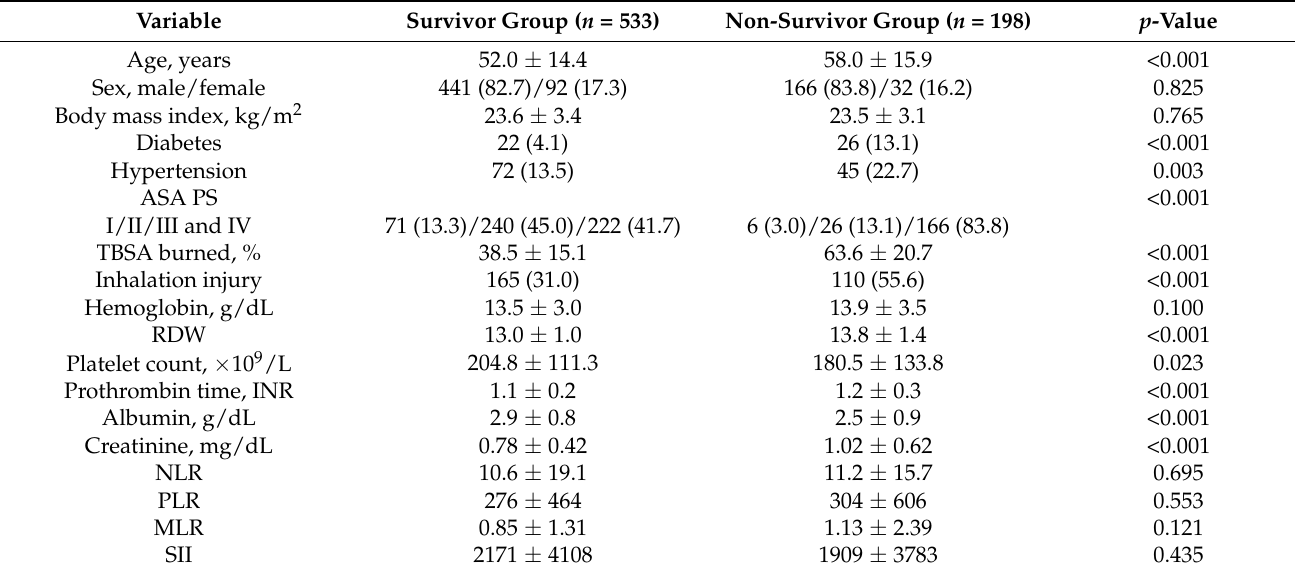
Table 1. Baseline characteristics and laboratory findings of the survivor and non-survivor groups 90 days after burn surgery.